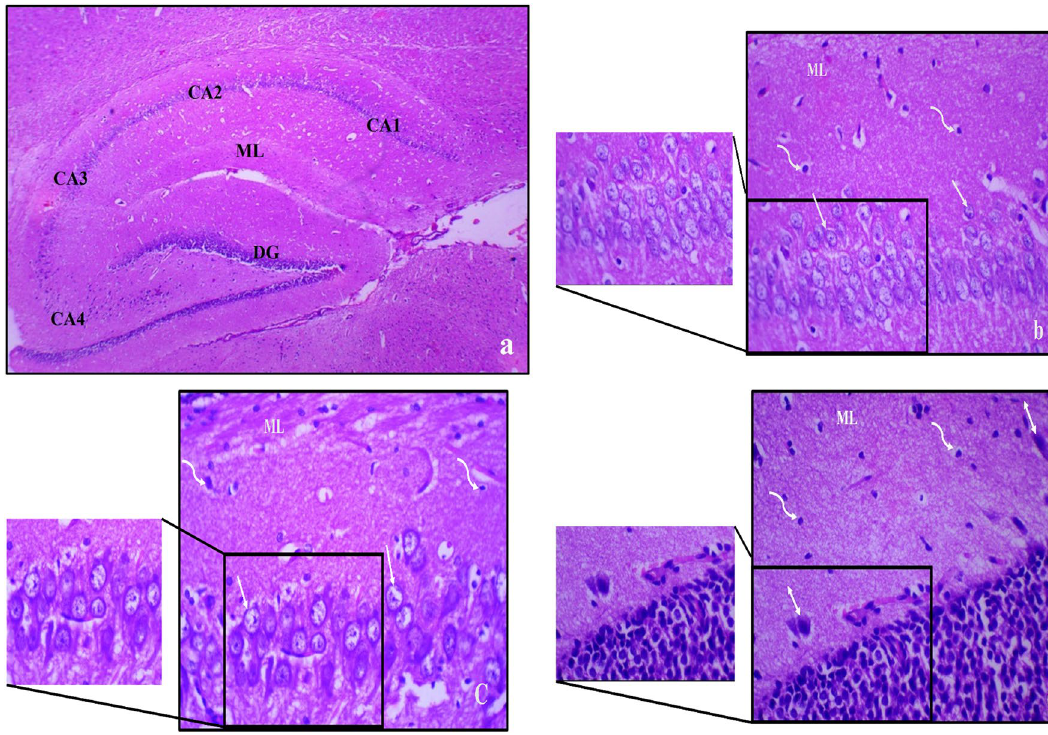
Figure 6. Photomicrograph of haematoxylin and eosin-stained sections from hippocampus of control female rat showing normal regions and histological structure of the hippocampus, where; ( a ) The hippocampus proper is formed of the Cornu Ammonis (CA) as CA1, CA2, CA3 & CA4 regions, and is continued as subiculum (S). Dentate gyrus (DG) is seen around CA4 by its upper & lower limbs. Molecular layer (ML) is in between CA and of DG (H & E ×40). ( b ) 4–5 compact layers of small pyramidal cells of CA1 region, most with vesicular nuclei ( ↑ ); ( c ) shows few layers of large pyramidal cells in CA3 region, also with vesicular nuclei ( ↑ ); ( d ) shows layers of compact granular cells with dark nuclei in dentate gyrus. Molecular layer (ML) shows many glial cells (wavy arrow) as well as pyramidal cells ( ↕ ) [H & E; ( a ) ×40, ( b – d )